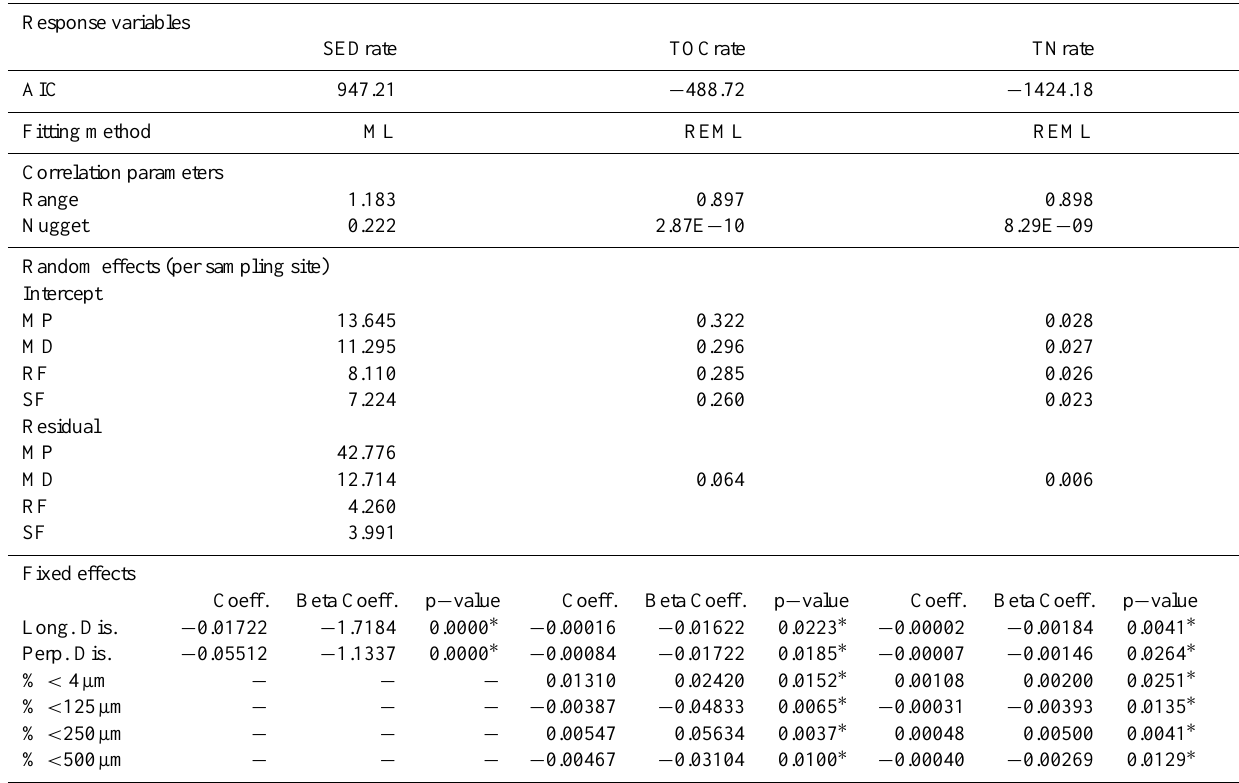
Table 4. Summary of the results of the generalized linear mixed-effects models for sedimentation rate (SEDrate), Total Organic Carbon (TOCrate) and Total Nitrogen (TNrate): Goodness of fit statistic value (AIC); Fitting method: Maximum Likelihood (ML) or Restricted Maximum Likelihood (REML); Correlation parameters; Random effects for sampling site and model corresponding to the intercept and, in the case of heterocedasticity, in the residuals; Coefficients of the fixed effects: Coeff., Beta Coeff. (standarized coefficients) and p-values for the sedimentation rate (SEDrate), Total Organic Carbon (TOCrate) and Total Nitrogen (TNrate) models. Long. Dis. = Longitudinal distance; Perp. Dis. = Perpendicular distance (see methods for